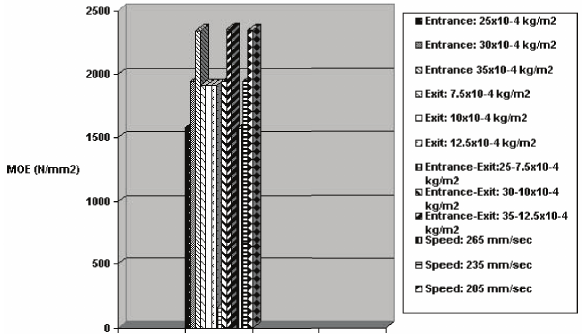
Figure 3. Effects of entrance and exit pressures, and feed- ing speed on the modulus of elasticity.